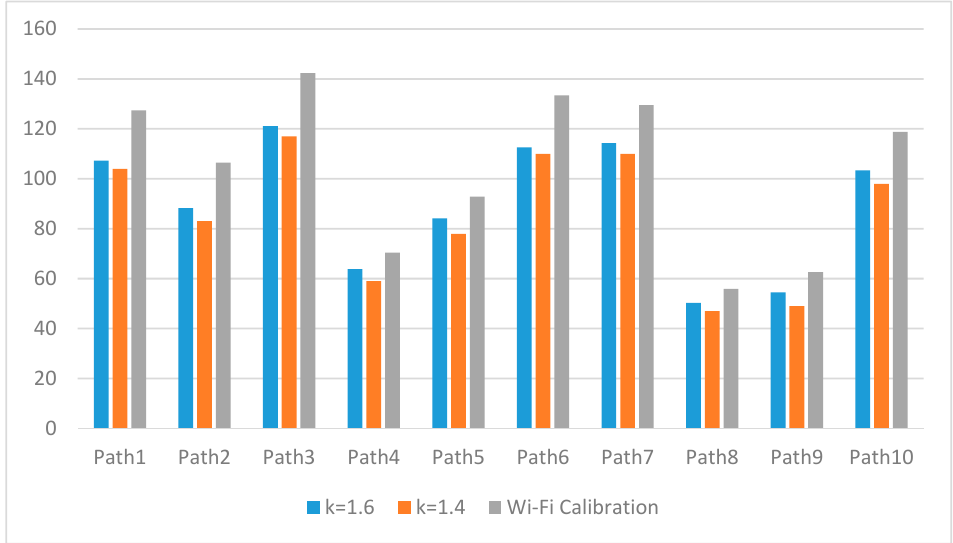
Figure 12. Comparison with Wi-Fi calibration (unit of y -axis: cm).